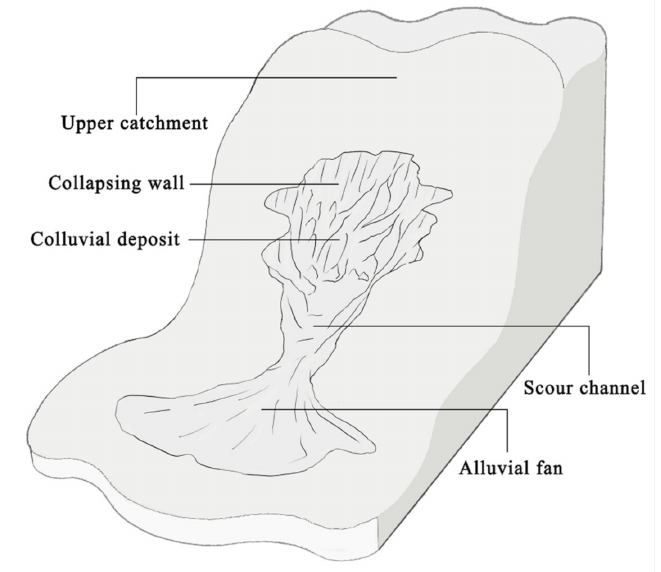
Figure 1. Sketch of Benggang erosion in the granite hills of South China.